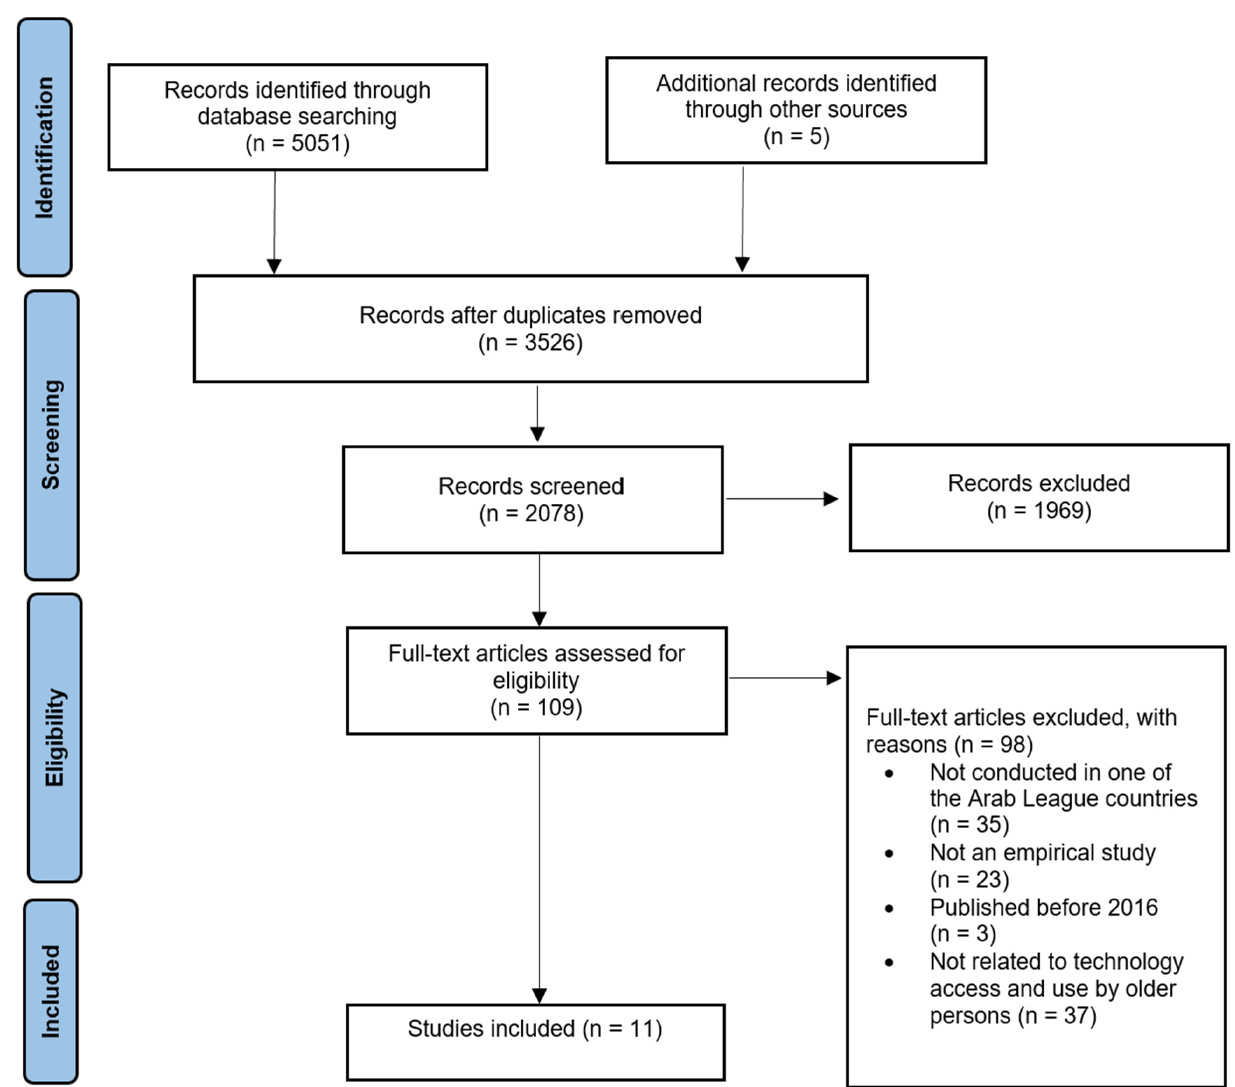
Figure 1. Flow chart of the study selection process.